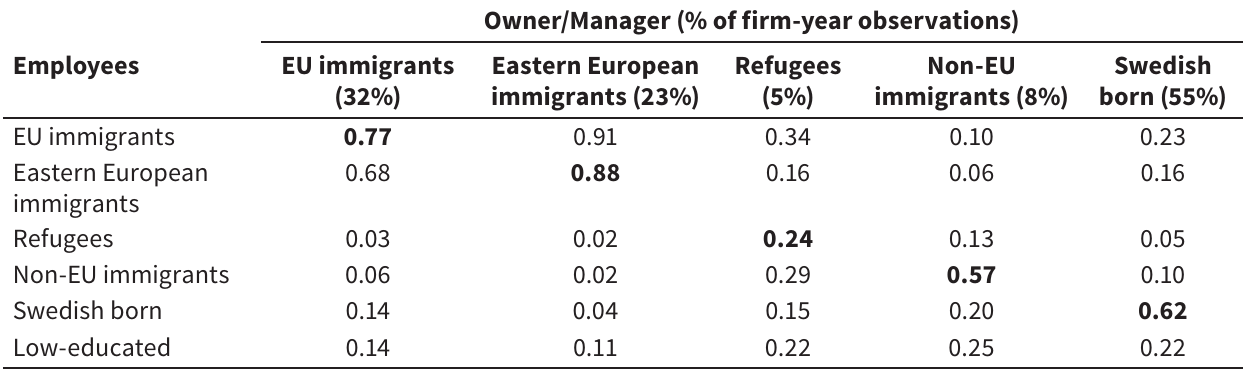
Composition of employees by the manager’s country of origin for subsidized firms Owner/Manager (% of firm-year